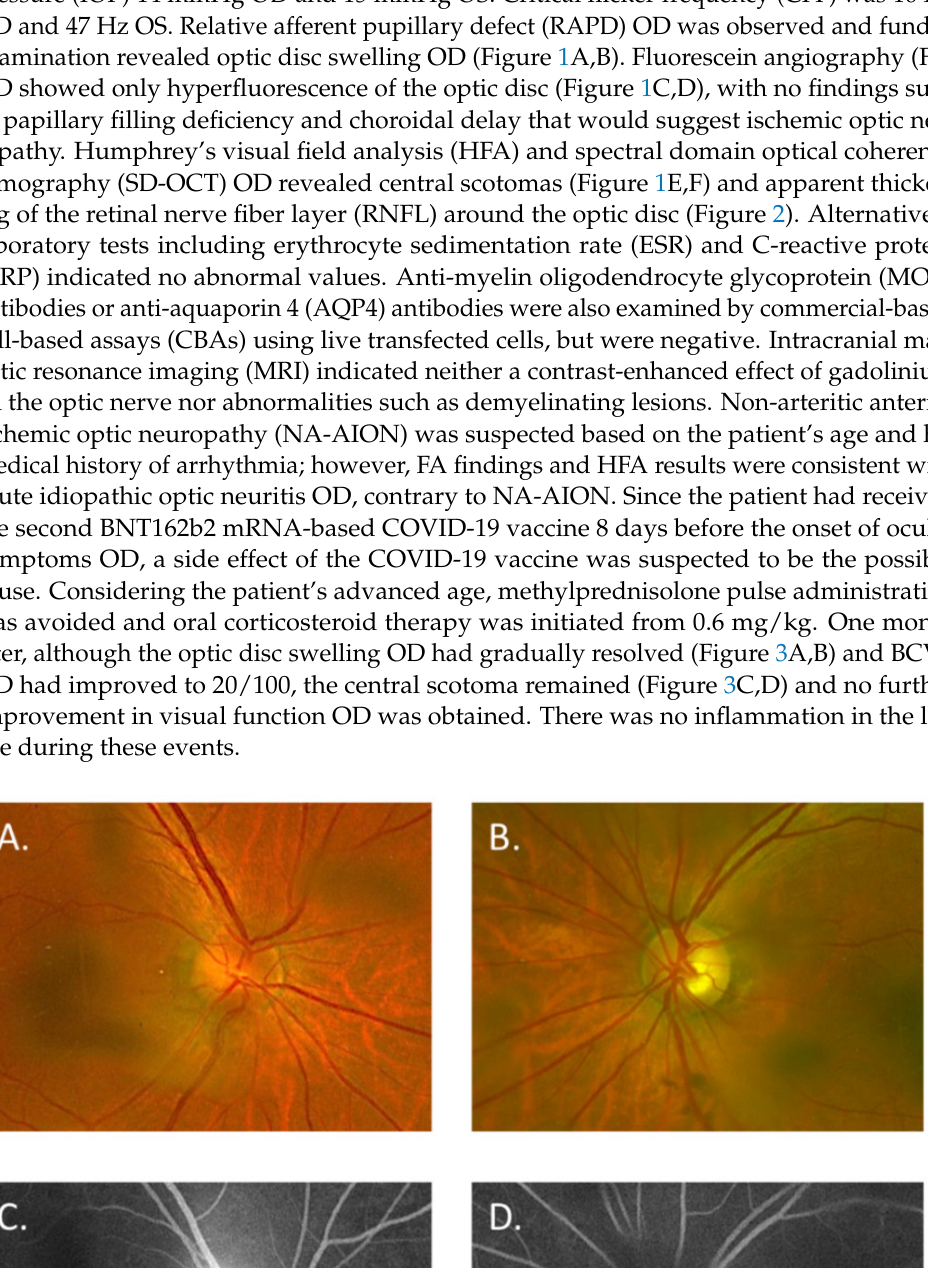
Figure 1. ( A , B ) color fundus photographs of the right eye ( A ) and left eye ( B ) 8 days after receiving the second COVID-19 vaccination. ( C , D ) fluorescein angiography findings in the right eye ( C ) and left eye ( D ) at the late stage. ( E , F ) Humphrey’s visual field analysis of the right eye ( E ) and left eye ( F ).